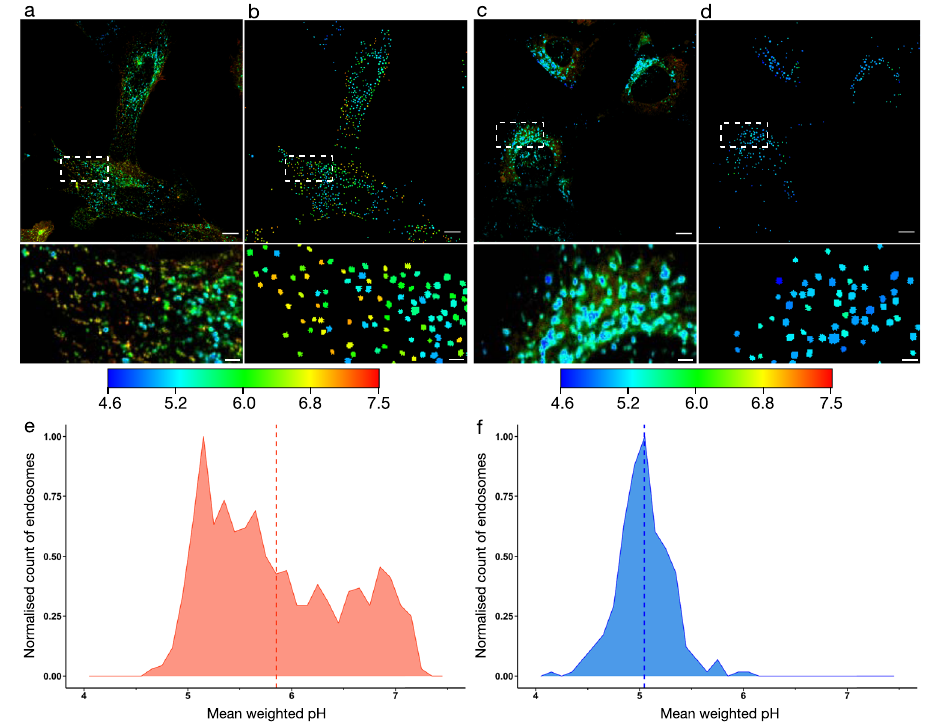
Fig. 3 | Employing an automated deep learning model to detect endo/lysoso- malcompartmentsenablesquanti fi cation oftheintracellularpHdistribution. a , c FluorescencemicroscopyimagesofNIH-3T3cellsexpressingTfR-mApple( a )or TMEM106b-mApple ( c ). Images pseudo coloured by a phasor mask (Fig. 1g) accordingtothecolourscaleshown. b , d Automated detectionofendo/lysosomes in ( a ), ( c ), respectively, pseudo coloured according to the indicated colour scale.